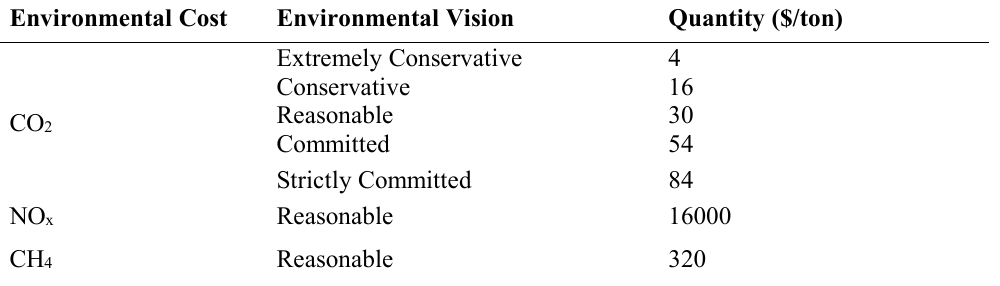
Table 10 : Environmental Costs of GHGs in different environmental visions (Smekens and van der Zwaan 2006; Tol 2003; Waldhoff et al. 2014)